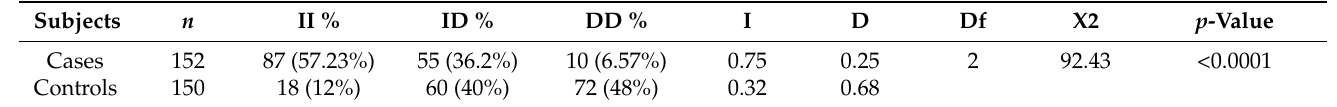
Table 4. Genotype distribution of ACE I/D rs4646994 between T2D cases and controls.